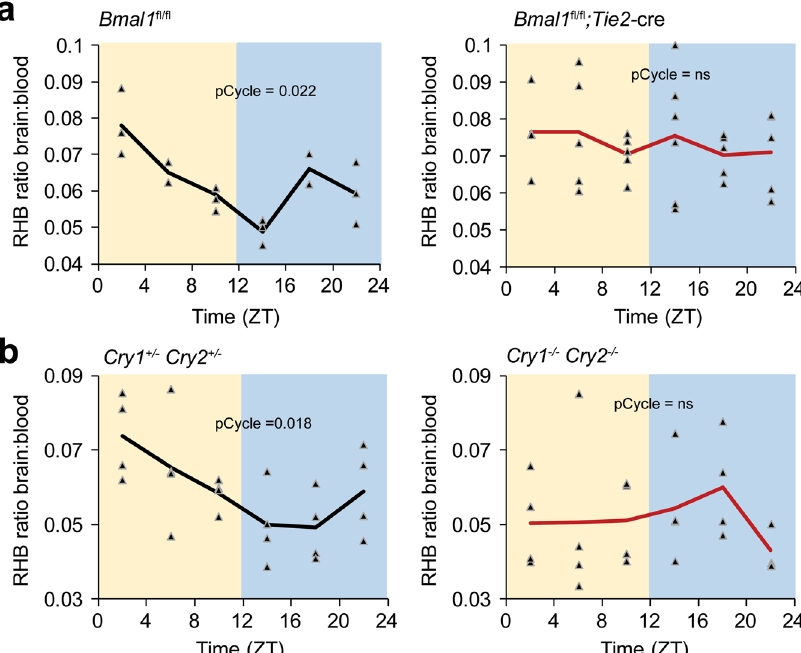
Fig. 2 A circadian clock in the BBB regulates brain permeability of RHB. RHB was intravenously injected via jugular vein into mice. Mice were allowed 90 min to recover and brains and sera were collected. Fluorescence was read at ex540/em590nm using a plate reader. a Clock ablation in endothelial cells disrupts the brain permeability rhythm to RHB. RHB was injected into control ( n = 18; 4 independent experiments) or endothelial-speci fi c Bmal1 -de fi cient ( n = 31; 4 independent experiments) mice at indicated time points. b Global circadian disruption ablates brain permeability rhythm to RHB in mice. RHB was injected into Cry1/2 het ( n = 24; 3 independent experiments) and Cry1/2 DKO ( n = 23; 4 independent experiments) mice at indicated time points. Individual mice are shown with triangle markers, and lines represent the mean. pCycle values were calculated by JTKCycle